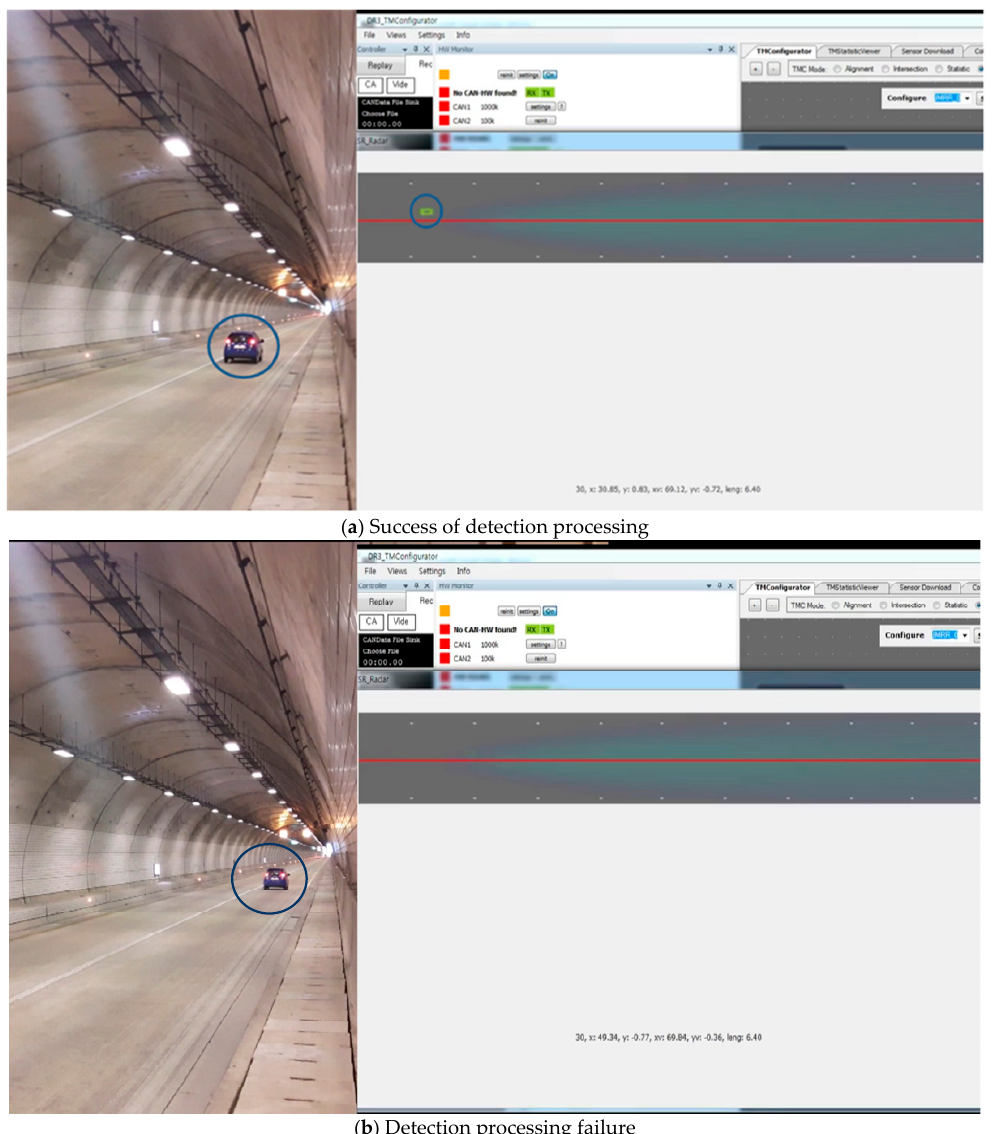
Figure 17. Example of detection processing delay.